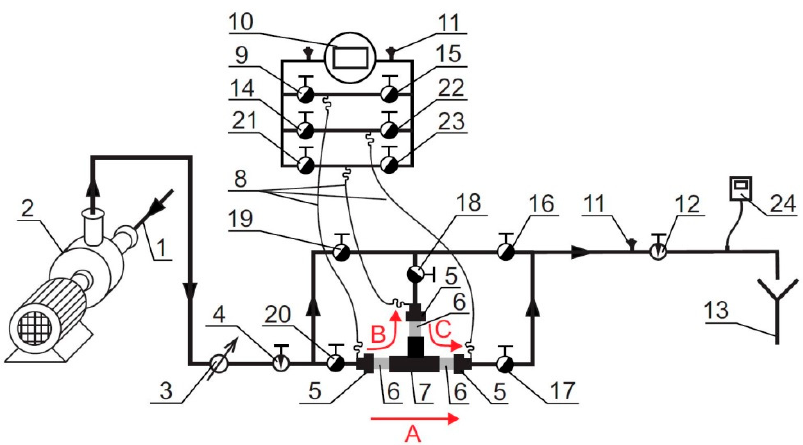
Figure 1. Scheme of the test rig for investigations of hydraulic resistance of polypropylene T-junctions: